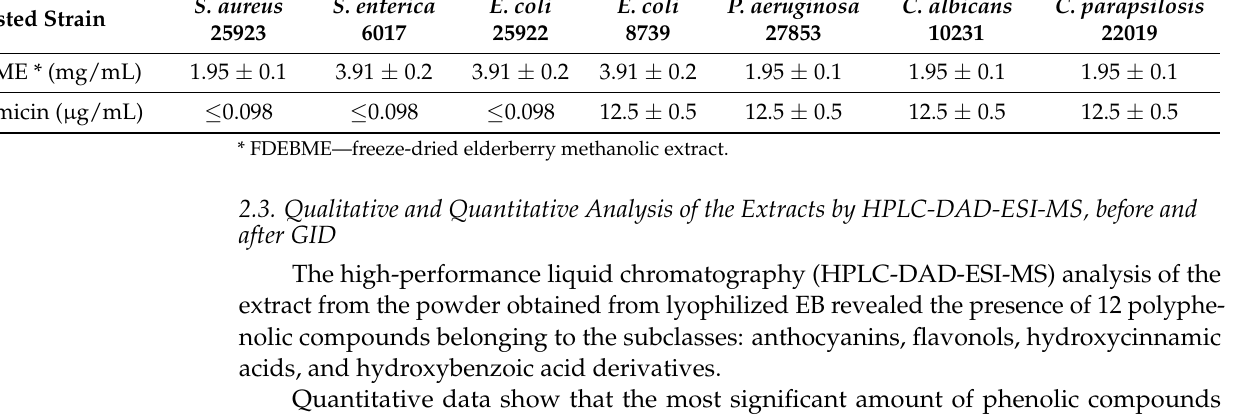
C. albicans C. parapsilosis 10231 22019